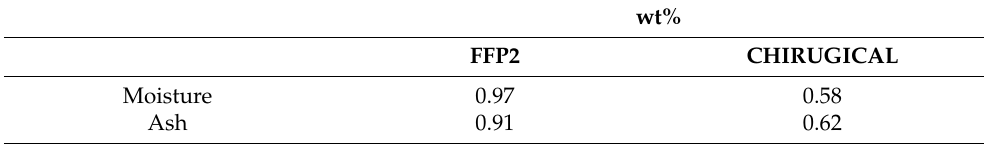
Table 2. Moisture and ash determination of FFP2 and chirurgical masks as received (EN 15414-3:2011).